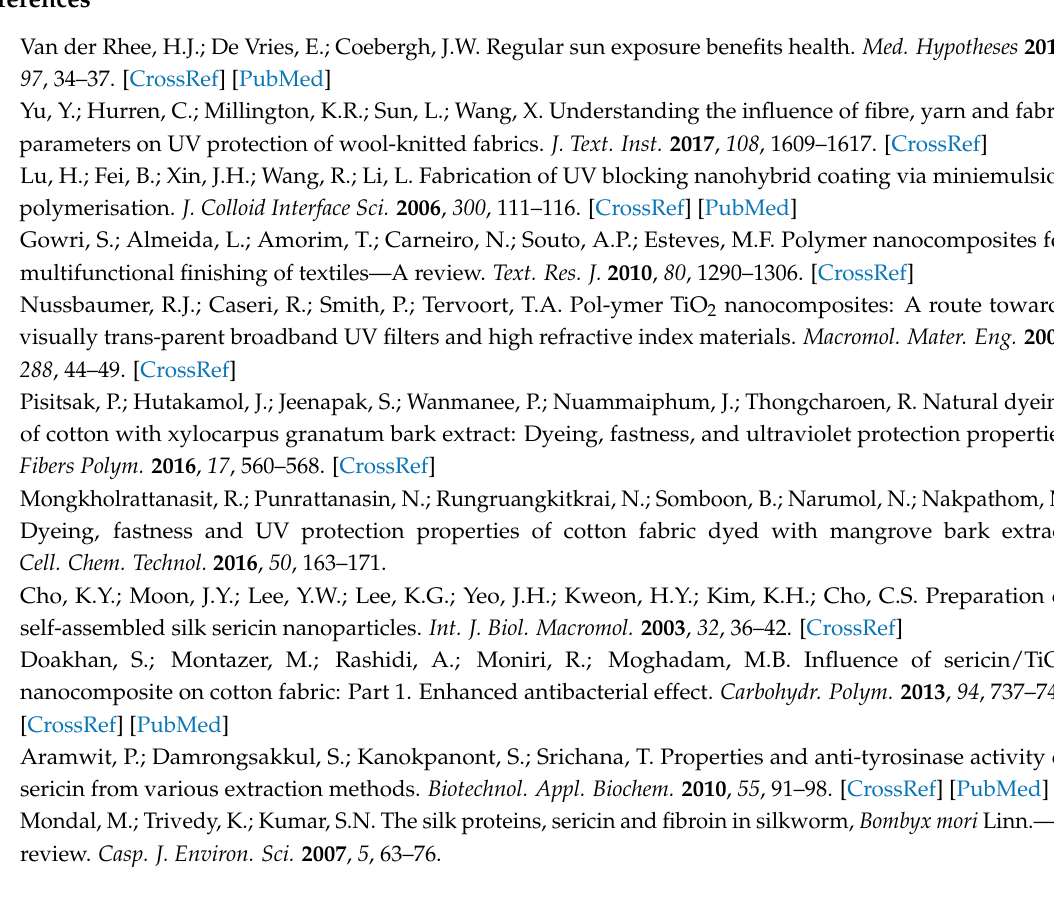
Figure S1: Predicted vs experimental values for ( a ) UPF, ( b ) %reduction of E. coli , and ( c ) %reduction of S. aureus